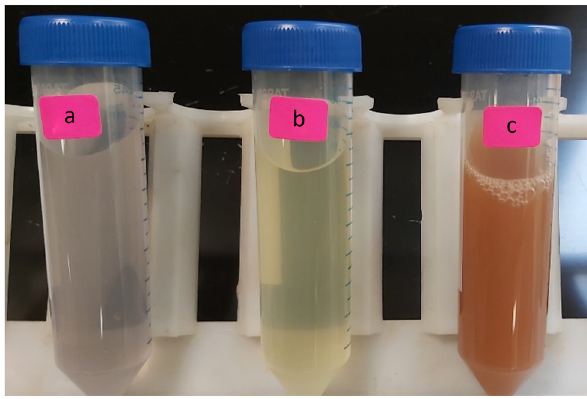
Figure 1: A. vera gel extract ( a ) , a mixture of aqueous silver nitrate and gel extract after 10 min ( b ) , and after 45 min ( c ) , production of Ag - NPs using A. vera gel extract as green